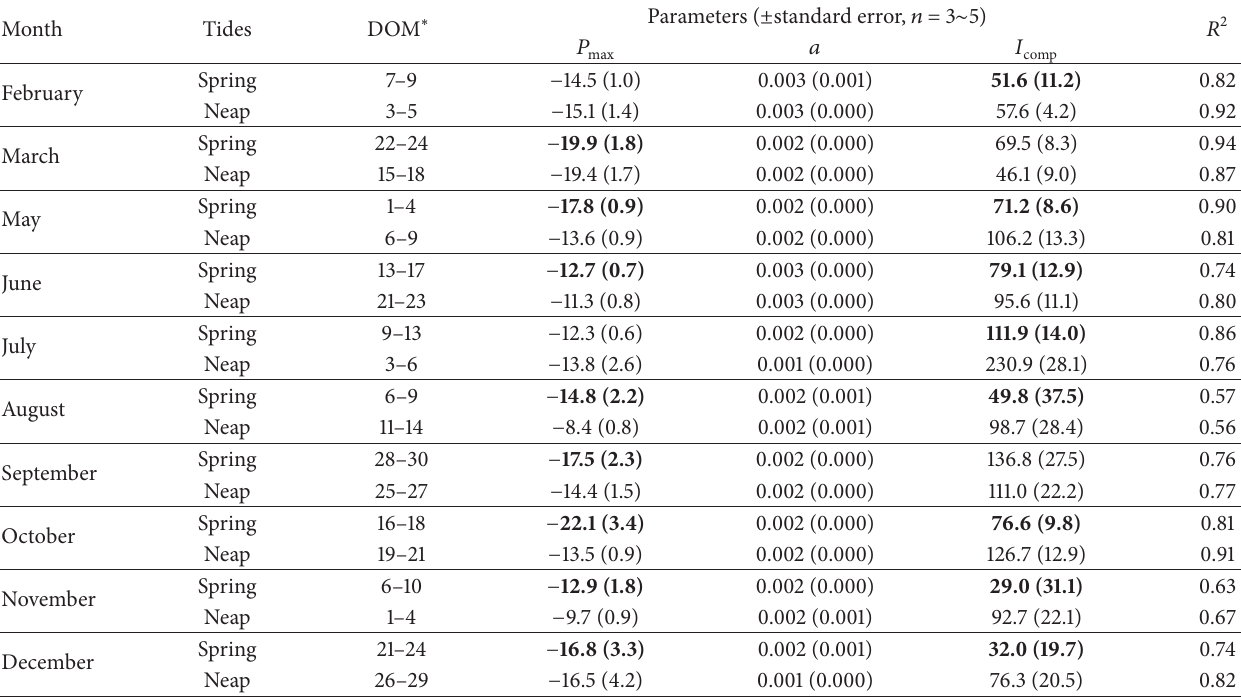
Table 2: Parameters and 𝑅 2 values using the Landsberg model (see (2) in the text) fitted to the daytime net ecosystem change of CO based on photosynthetic active radiation (PAR) in 10 months of the year 2010 for the mangrove forest of Zhanjiang, Guangdong (GDZJ).